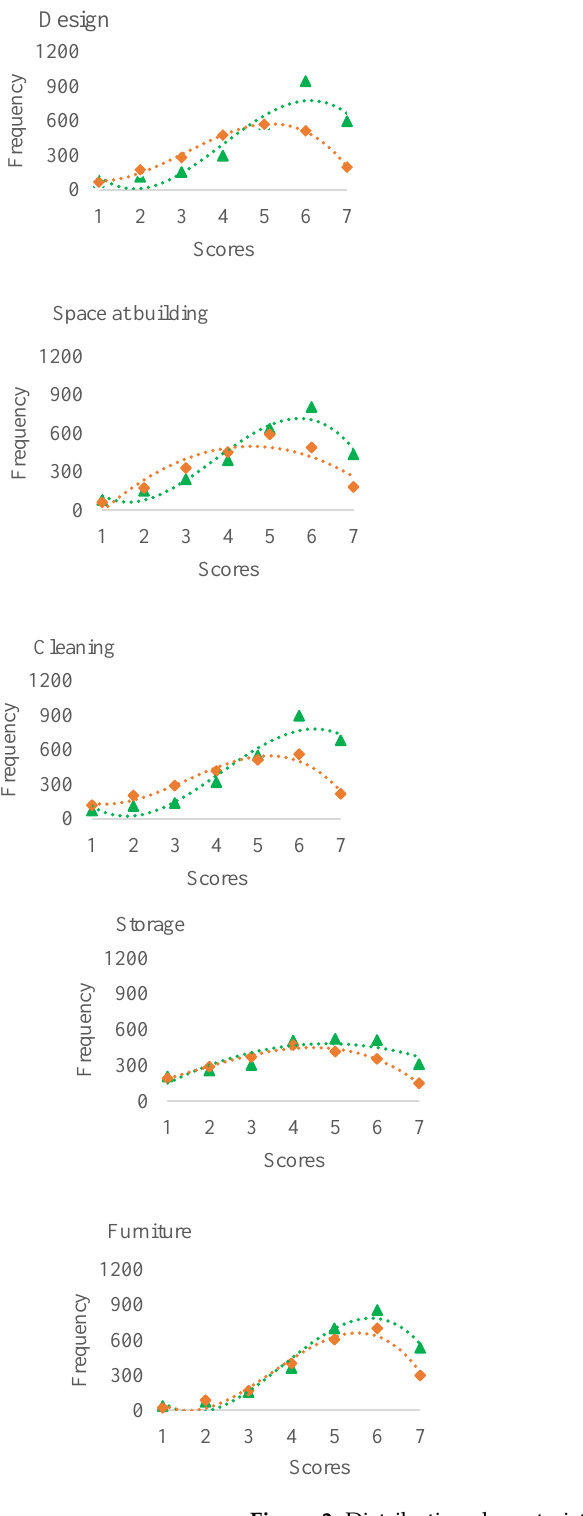
Figure 3. Distribution characteristics of median scores for operational parameters.